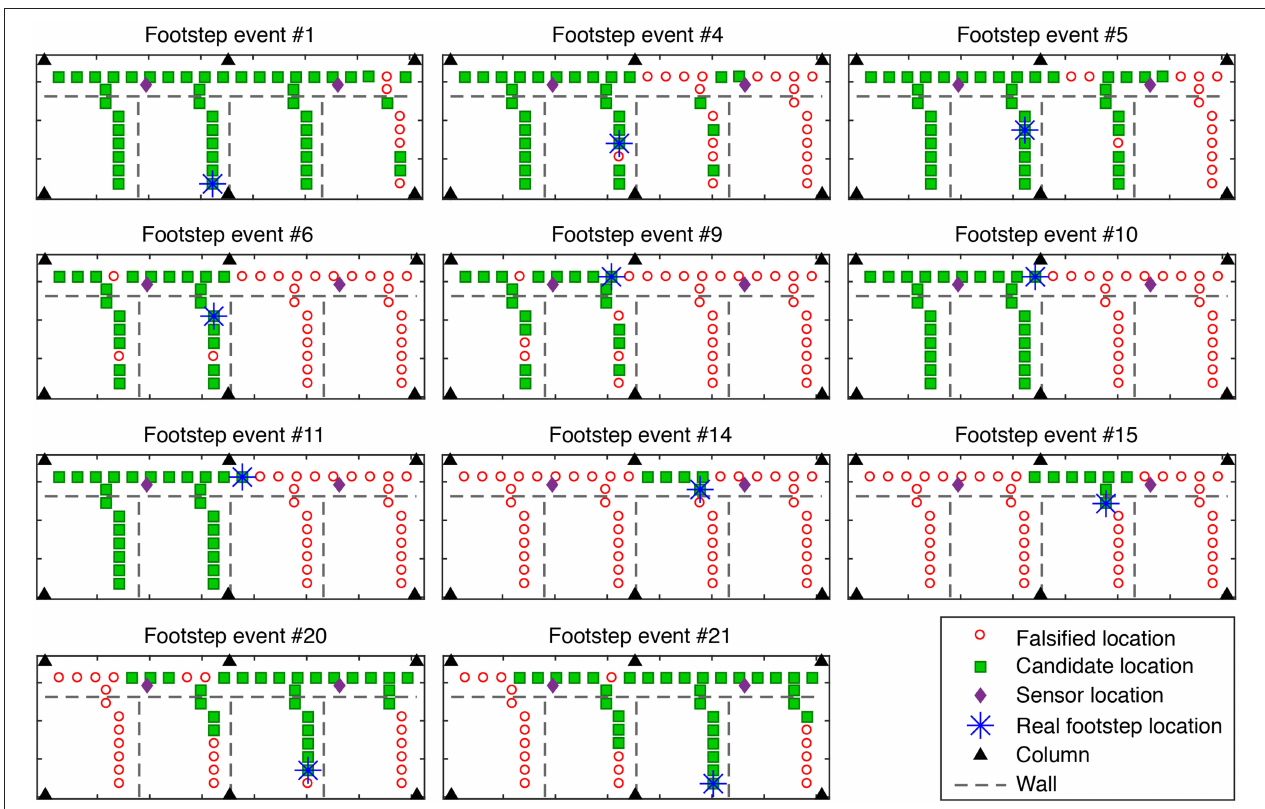
FIGURE 11 | Candidate-location set that is obtained using EDMF and sequential analysis (see Figure 3 ) for each footstep event of trajectory #3.